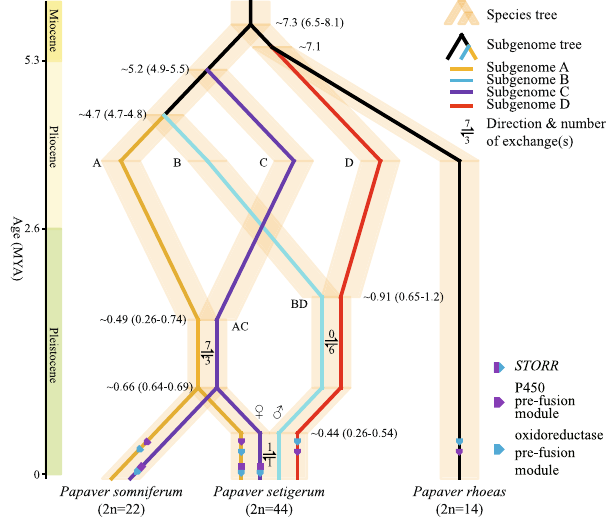
Fig. 2 | The reticulate allopolyploidization model in the three Papaver species and the subgenomic locations of STORR and its pre-fusion loci. The times of species/subgenomes divergence and hybridization shown on the topology were based on median K s values and the subgenome-speci fi c LTR-RT insertion times, respectively, see Supplementary Tables 3, 4 for details. The currently retained copies of STORR and its pre-fusion modules are sorted to subgenomes (see more detailsinSupplementaryFigs.13 –